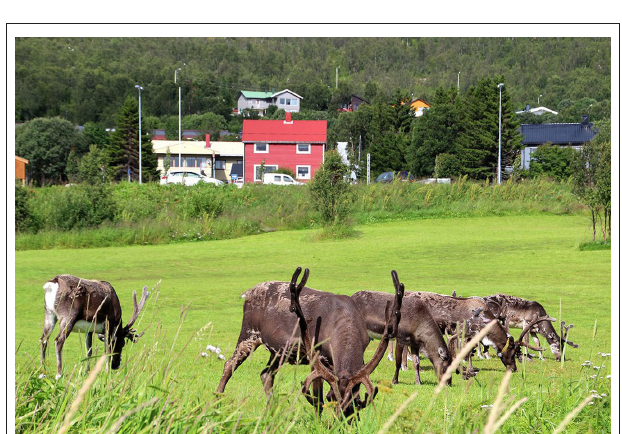
FIGURE 17 | Illegal grazing: herders are not allowed by law to graze reindeer on actively cultivated ground (Government of Norway, 2007, §19). Are these male reindeer, enjoying a lawn on Kvaløysletta just outside Tromsø, Norway, encroaching on cultivated ground or has cultivation encroached on traditional reindeer pasture? Photograph: Bjørn